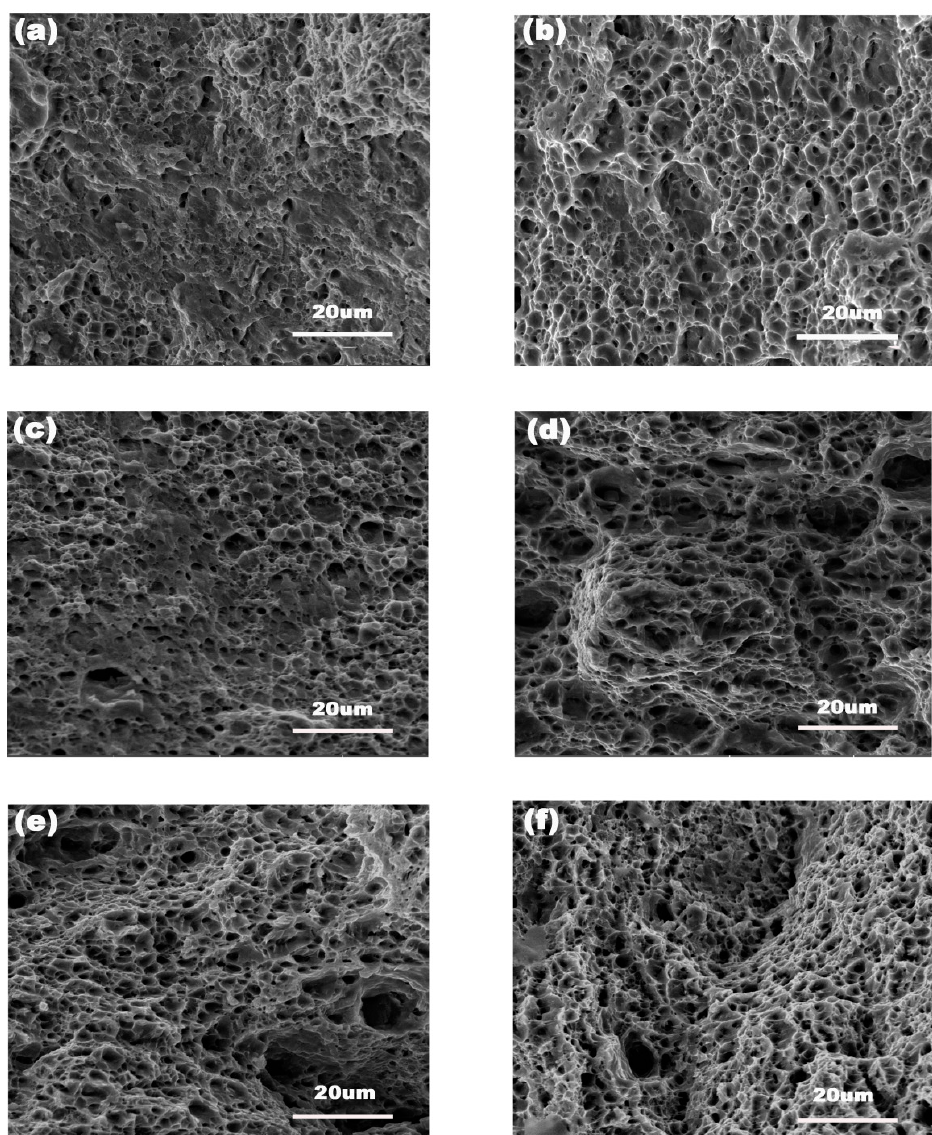
Figure 15 . Fracture morphology at ( a ) location C1 at 300 °C, and ( b ) 500 °C; and ( c ) location H1 at Figure 15. Fracture morphology at ( a ) location C1 at 300 ◦ C, and ( b ) 500 ◦ C; and ( c ) location H1 at 300 °C, ( d ) 400 °C, ( e ) 500 °C, and ( f ) 600 °C. 300 ◦ C, ( d ) 400 ◦ C, ( e ) 500 ◦ C, and ( f ) 600 ◦